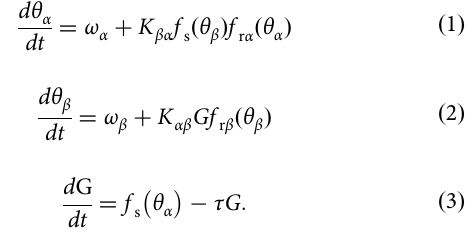
Fig. 4 α Cell activates after β cell with a fi xed time delay while β cell activates after α cell with variable time delay. a Left: Each oscillation cycle is de fi ned as the interval between two β cell activations (see Supplementary Fig. 3 for alternative ways to de fi ne the period T ). Right: 13 features of α - β oscillation cycle are used to construct the feature matrix (columns represent features, rows represent oscillation cycles). b Left: Oscillation cycles are separated into two clusters by using UMAP, with the mean oscillation period ( T ) of each cluster shown ( n = 658 cycles from 21 islets, the fast and slow clusters have 574 and 84 oscillation cycles, respectively). Right: Mean Ca 2 + traces (bold line) and 15 representative traces (thin line) of fast clusters (top panel) and slow ones (bottom panel), aligned at the peaks of β cell Ca 2 + activity (arrows). c Histogram of phase difference ( Δ θ ), oscillation period ( T ), waiting time of α cells ( T βα ), and Full Width at Half Maximum of α and β cells ( α FWHM , β FWHM ) in fast and slow clusters de fi ned in Fig. S3. d Left: Scatter plot of Δ θ versus T . Dashed lines indicate in-phase and anti-phase α and β oscillations. Right: Scatter plot of T βα versus T . The blue and orange dots represent the fast and slow clusters from all 21 islets in b . The red, green, and dark blue dots represent the oscillations from fast, mixed, and slow islets shown in Fig. 5d (right panels) (See Supplementary Fig. 4b – d for scatter plots of other ways to de fi ne the period). e Left: Mean Ca 2 + traces of α and β cells when the glucose stimulation was shifted from 3 G to 10 G. The rectangle box showed 38 α and β phase-locked oscillations. Right: T , T βα , and Δ θ of 38 oscillation cycles.